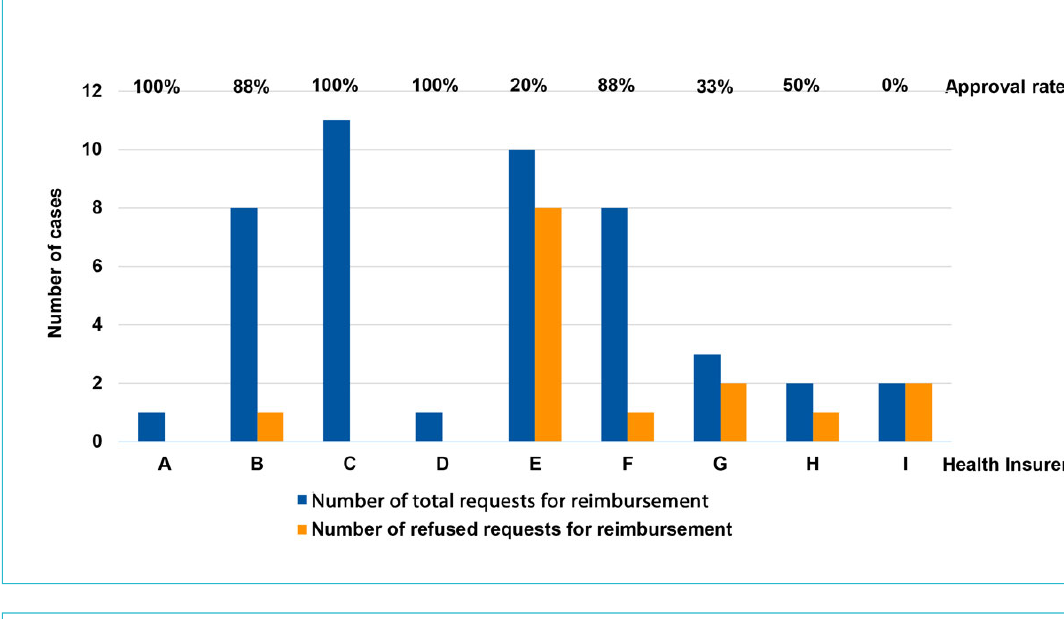
Figure 2: Total number of requests (blue) and refused requests (orange) for reimbursement per health insurer A–I. Reimbursement rates are given in percentages.